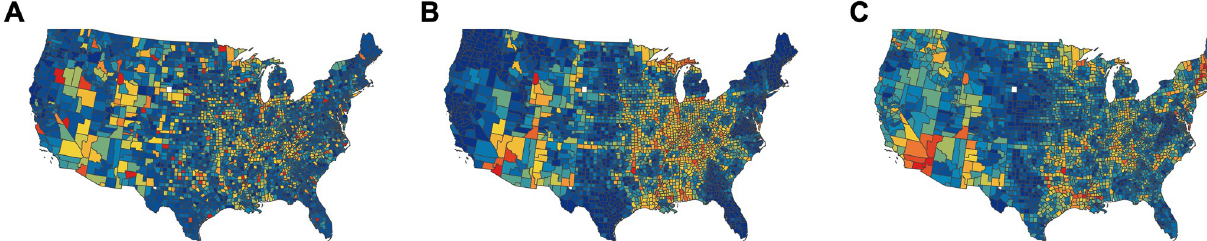
Fig 4. Distribution of target edges reflected by county-level colours. A county is coloured red if intervention is applied to most edges incident to it, a county is coloured dark blue if intervention is applied to very few edges incident to it. (A) SP intervention. (B) CF intervention. (C) LF intervention, λ = 1/ 50. The plots are made with base map data from Natural Earth @ naturalearthdata.com. Direct link to base map data: https://www.naturalearthdata.com/